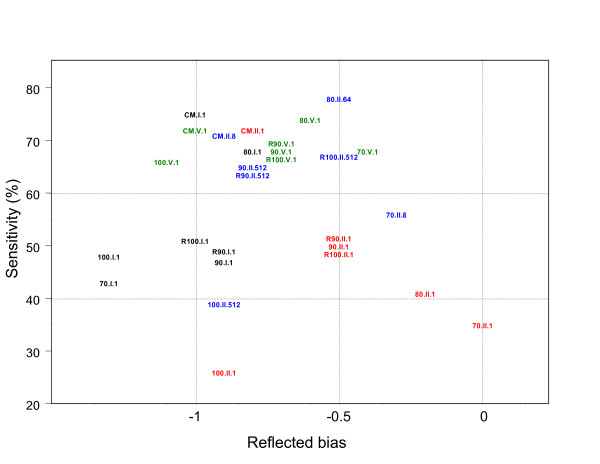
Reflected bias and sensitivity for selected normalizations. Reflected bias and sensitivity for 24 normalizations using four types of procedures for filtration, background adjustment, and censoring: complete filtration without background adjustment and censoring (black), complete filtration with background adjustment but without censoring (blue), complete filtration with background adjustment and optimal censoring (red), and partial filtration without background adjustment and censoring (green).